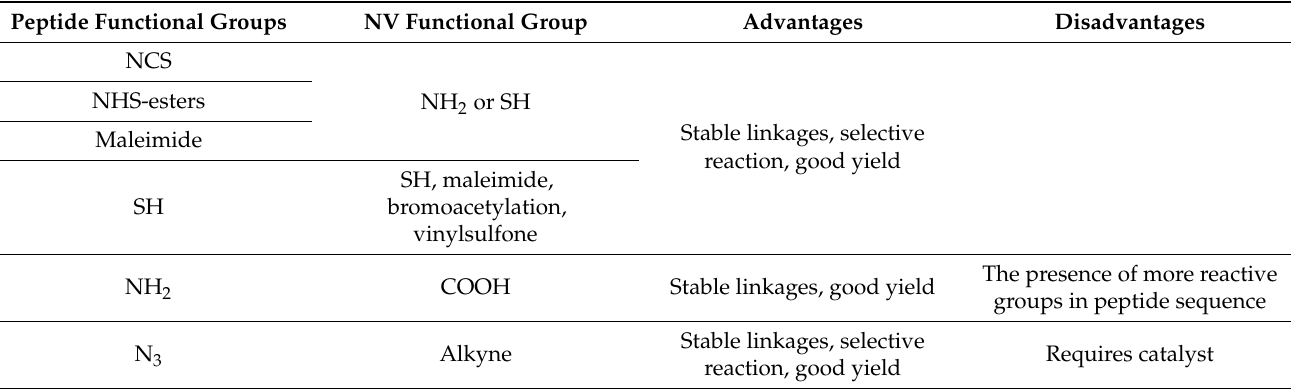
Table 2. The most popular methodologies used for covalent